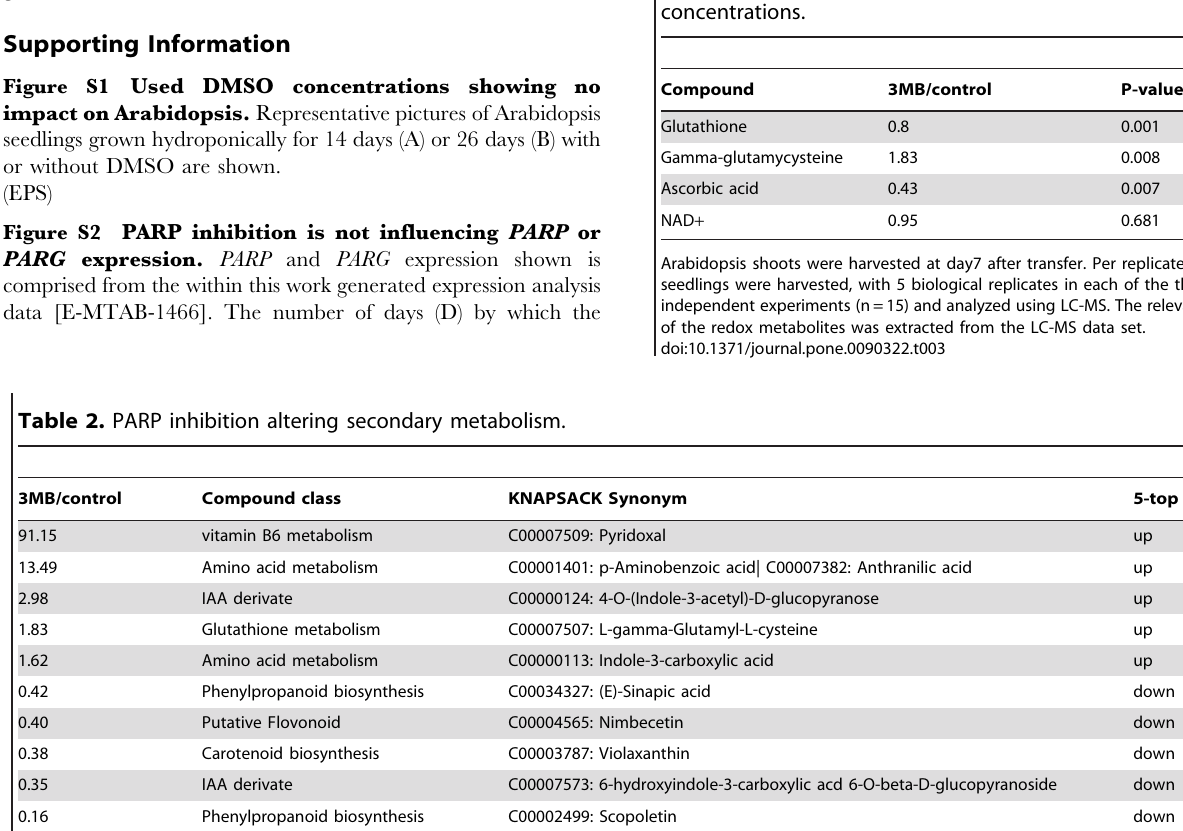
Table 3. PARP inhibition affects redox metabolite concentrations.